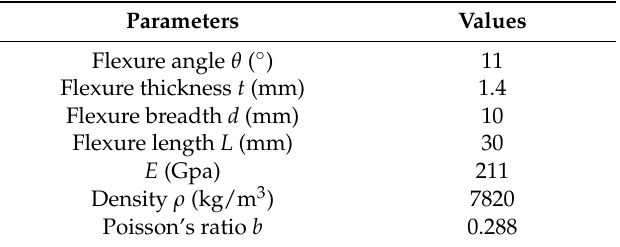
Table 5. Key geometric and material parameters of the diamond amplifier.